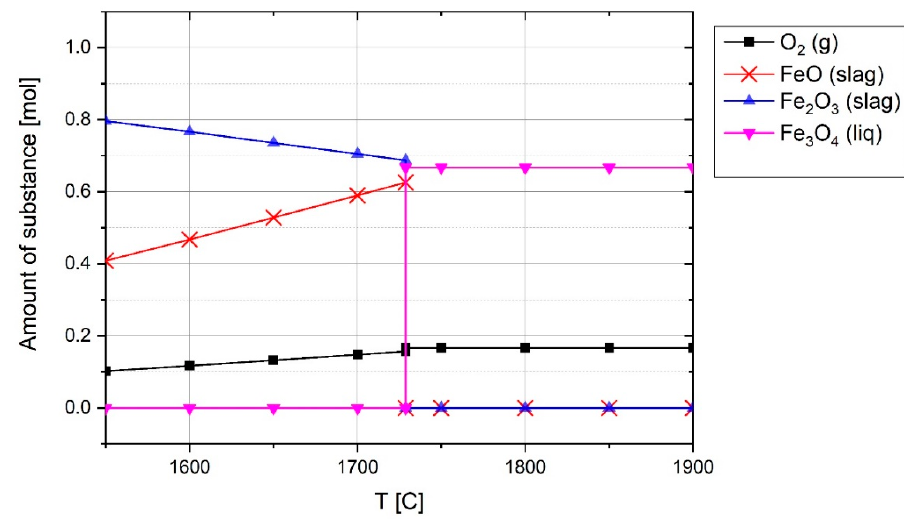
Figure 9. Chemical composition of 1 mol haematite over temperature at equilibrium at 1 atm pressure.